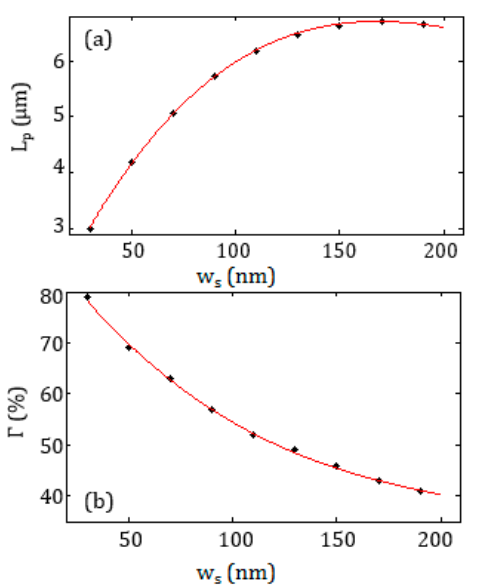
Figure 3. ( a ) Propagation length L p and ( b ) confinement factor Γ as a function of the waveguide width, w s .